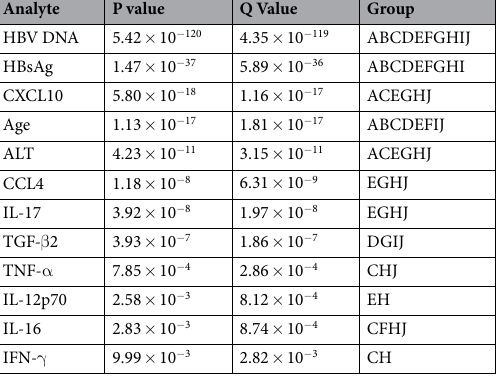
Table 2. Evaluation of significant differences between different phases of chronic HBV patients by using Kruskal-Wallis ANOVA (A = EPI vs. EPH; B = EPI vs. ENI; C = EPI vs. ENH; D = EPH vs. ENI-HR; E = EPH vs. ENI; F = EPH vs. ENH; G = EPH vs. ENI-HR; H = ENI vs. ENH; I = ENI vs. ENI-HR; J = ENH vs. ENI-HR)